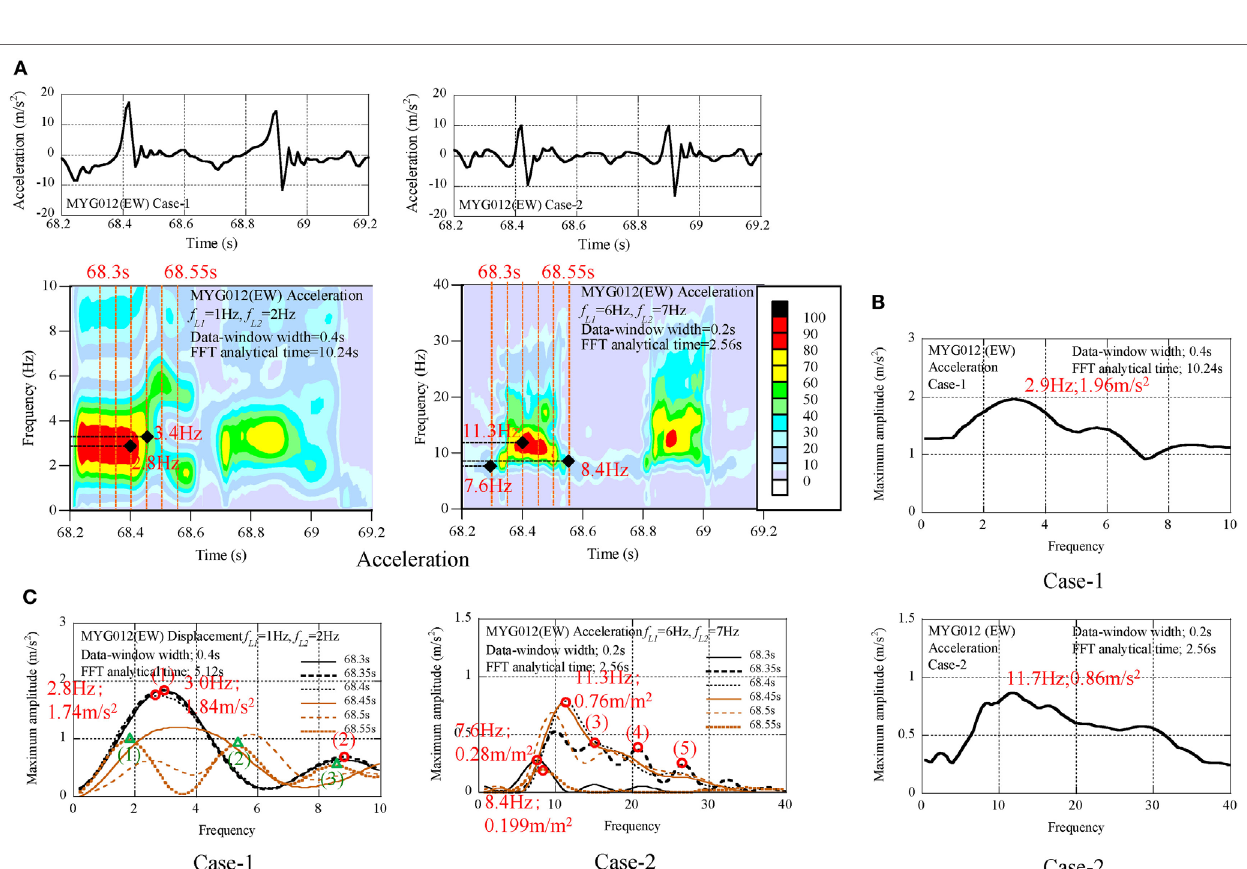
FigUre 6 | Natural modes of shear-spring model.